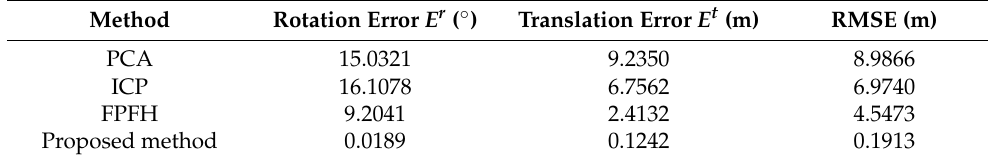
Table 1. Alignment accuracy parameters of Experiment